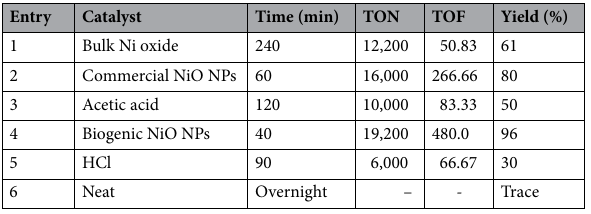
Table 3. Comparison the efficacy of different catalysts in 5g product preparation.